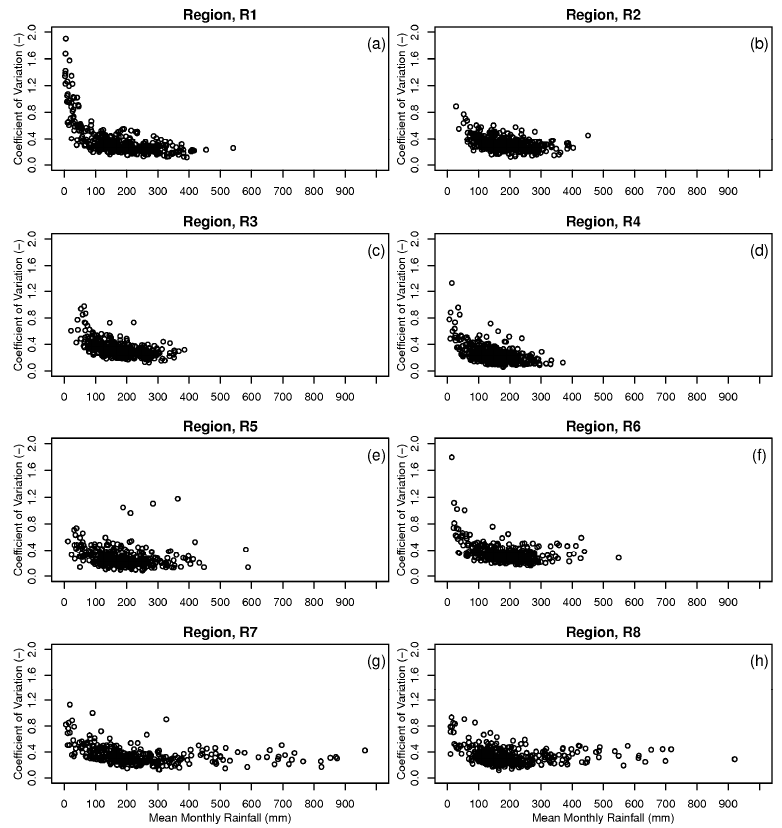
Figure 3. Mean monthly rainfall coefficients of variation over the eight delineated rainfall regions (Panel a to h ) for the period of 1976–2006.